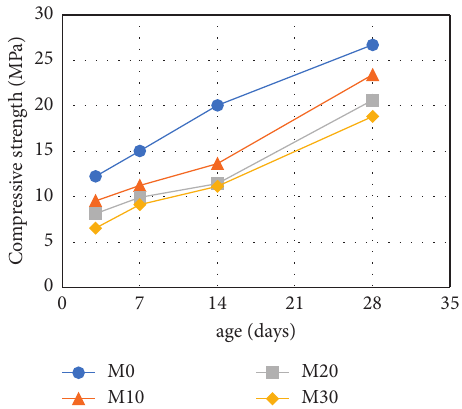
Figure 6: Effect of age on compressive strength of concrete.